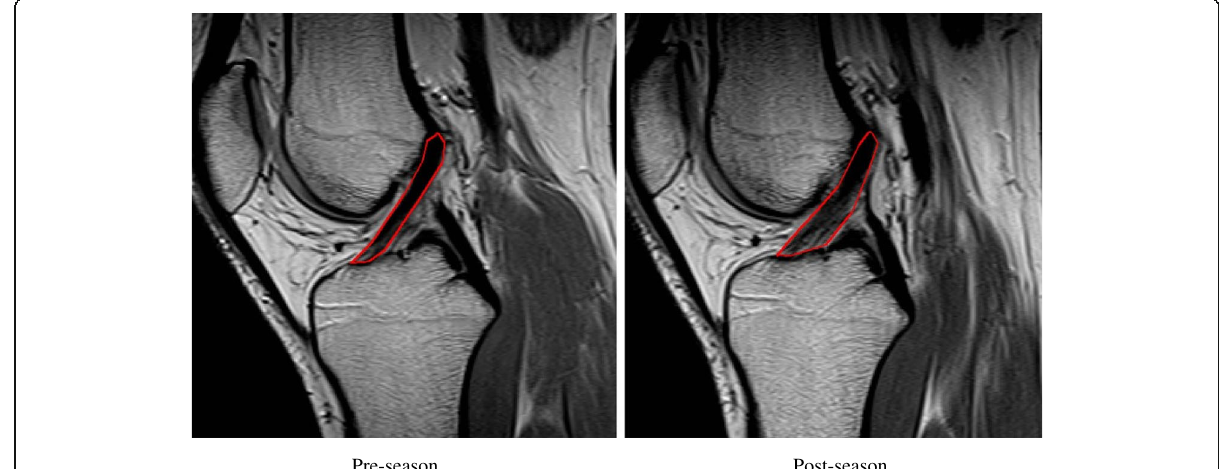
Fig. 1 MRI Image of Same Knee at Pre and Postseason